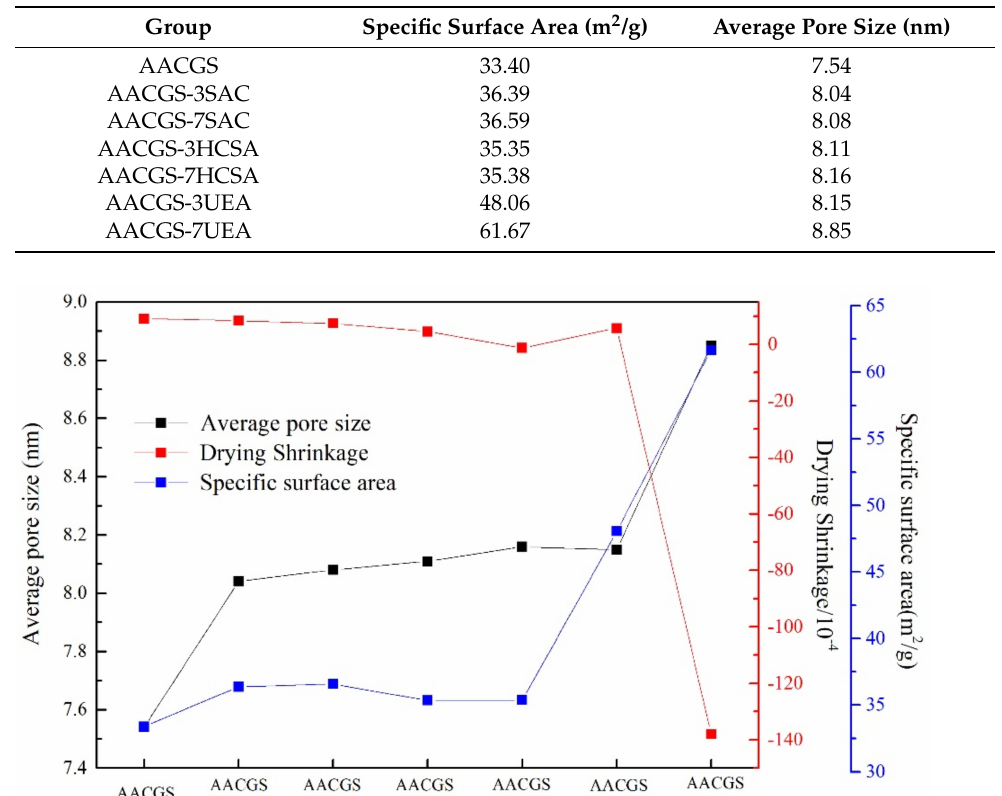
Figure 5. Relations between drying shrinkage and pore